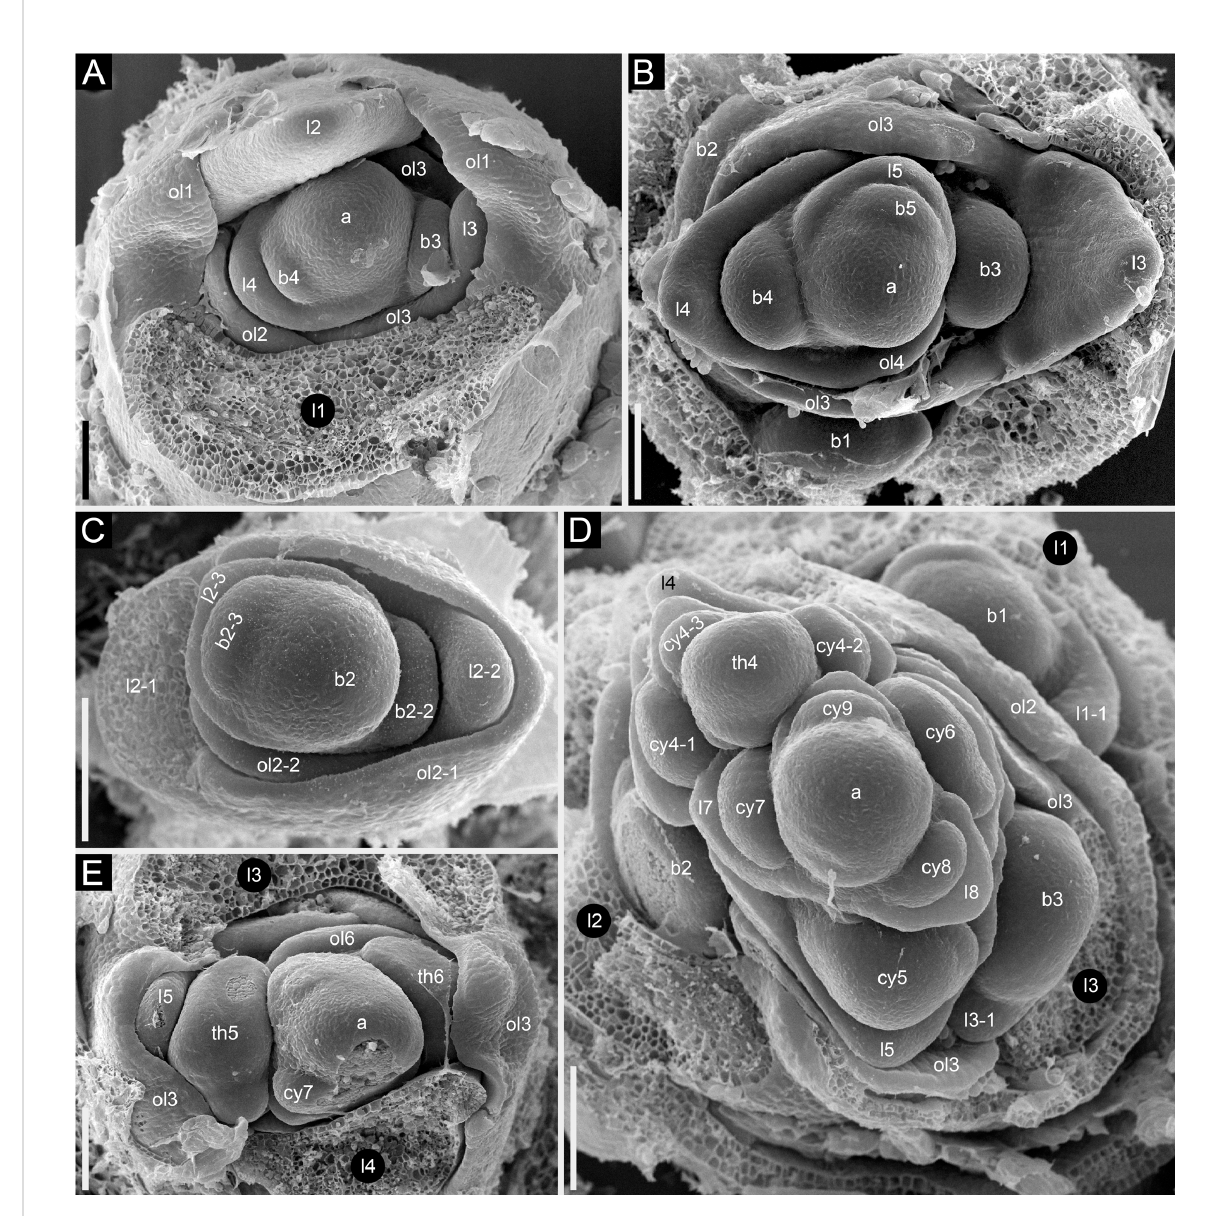
FIGURE 13 Developmental morphology of cultivars of Fagopyrum esculentum subsp. esculentum with determinate growth (SEM). (A – C) cv. Dozhdik. (A) Top view of young main axis with cotyledons and the fi rst proper leaf removed. Branches in axils of leaves 3 and 4 visible here have a potential to develop into branched paracladia. (B) Top view of young main axis with cotyledons and two fi rst proper leaves removed. Branches in axils of leaves 1 and 2 have a potential to develop into branched paracladia; the nature of other branches yet cannot be identi fi ed. (C) Top view of young paracladium developing in axil of leaf 2 of the main axis (adaxial side bottom). (D, E) cv. Temp. (D) Top view of young main axis with cotyledons and four fi rst proper leaves removed. Branches in axils of leaves 1-3 have the potential to develop into branched paracladia. (E) Top view of young main axis with cotyledons and three fi rst proper leaves removed. a, apex of the main axis; b, branch apex; cy, cyme; l, leaf (foliage leaf or cyme-subtending bract); ol, ocrea of leaf; th, thyrse apex. Leaves of the main axis are numbered (cotyledons not counted). Leaves of lateral axes have double numbers, the fi rst one being the number of the main axis leaf subtending the branch. Numbers of all axillary structures are those of their subtending leaves. Scale bars = 100 µm (A – E)